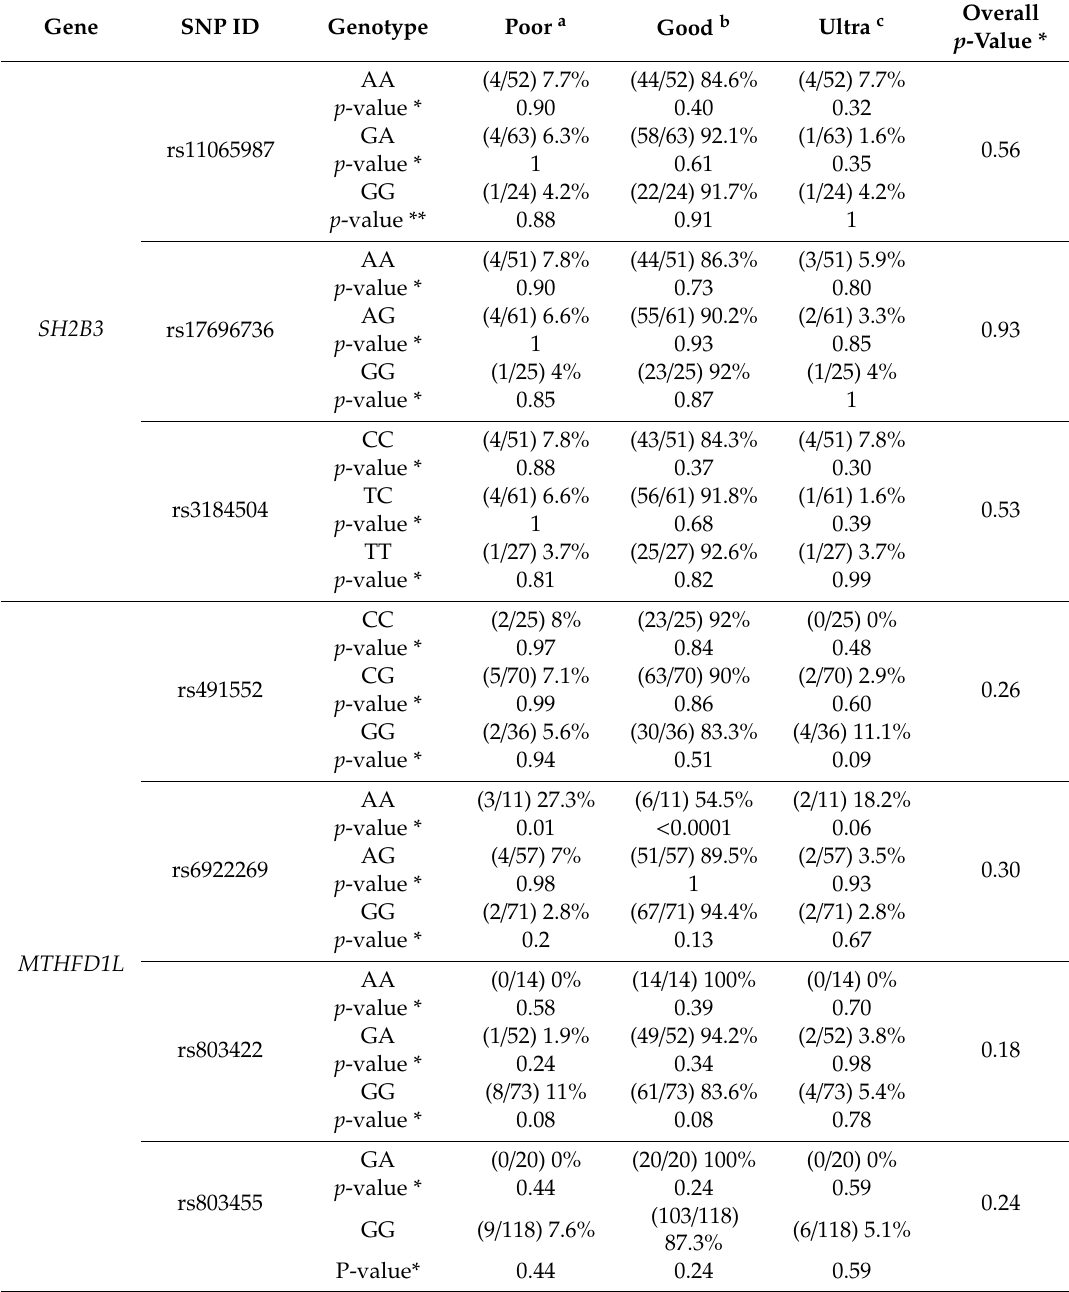
Table 6. Association of SH2B3 and MTHFD1L SNPs with warfarin responsiveness during the stabilization phase of therapy of 139 cardiovascular patients treated with